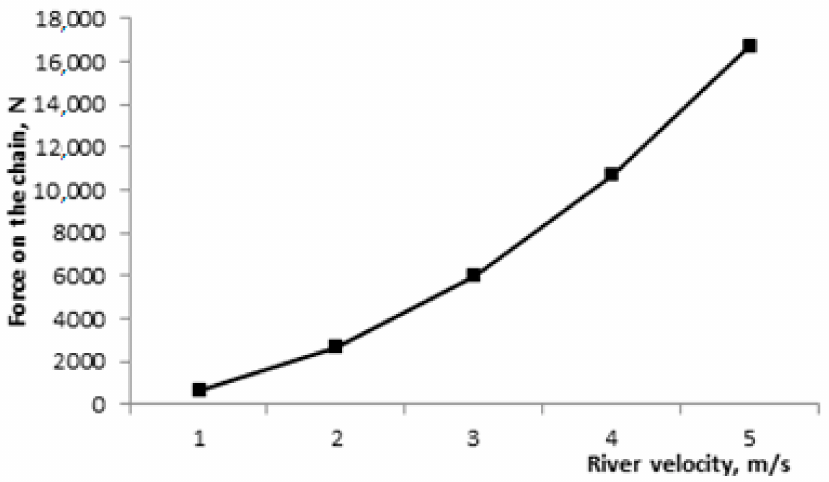
Figure 13. Simulation results at the velocity of 2.7